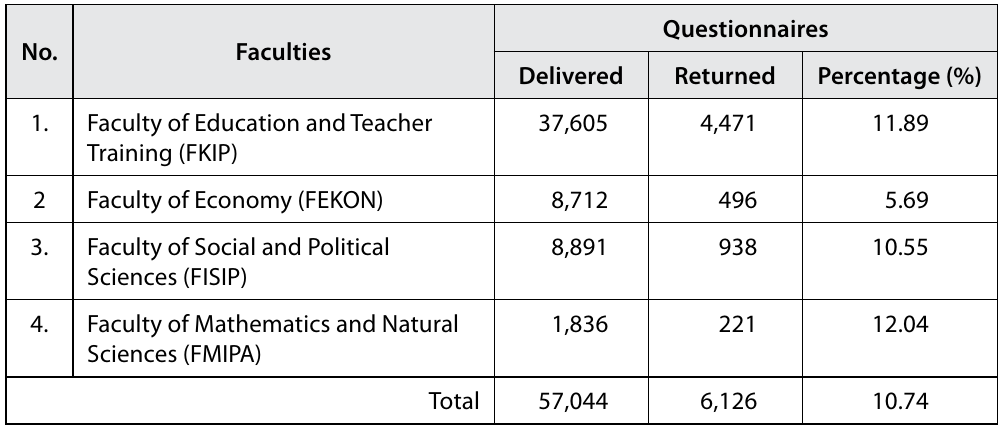
Table 2 Number of questionnaires